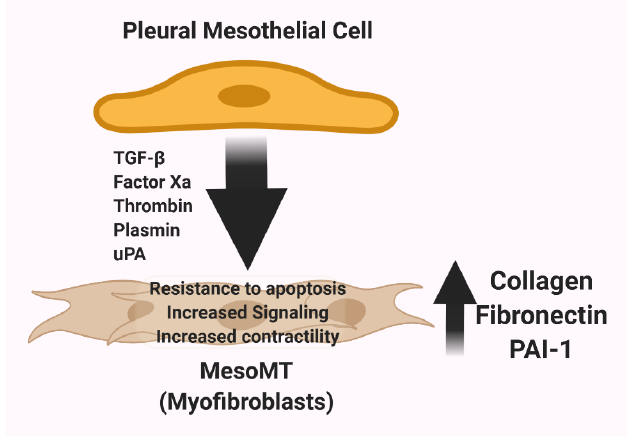
Figure 3. Induction and consequences of MesoMT. Upon stimulation by TGF-β, Factor Xa, throm- bin, uPA, or plasmin, pleural mesothelial cells assume a mesenchymal phenotype by undergoing MesoMT. The population of cells undergoing MesoMT expands in the setting of organizing pleu- ral inflammation. Cells undergoing MesoMT elongate compared to unstimulated pleural mesothe- lial cells and assume the functionality of myofibroblasts and increase expression of neomatrix components including collagen, fibronectin, and PAI-1. 5. The Role of Soluble uPAR in Pleural Injury: Biomarker, Effector, or Both? The structure of uPAR incorporates three domains: DI-III. High affinity binding to its ligand, uPA, primarily involves domain I, while requiring the structural integrity of all three domains [86]. Although a splice variant of the PLAUR gene can generate a soluble uPAR construct [87], soluble uPAR is also generated by cleavage of cell-surface uPAR and occurs in serum and other biologic fluids, including pleural effusions [88,89]. suPAR can be generated by cleavage of the GPI-anchor of uPAR at the cell surface by enzymes such as phospholipase C [90]. Cleavage of a protease sensitive linker region between domains I and domains II-III can also occur via uPA or plasmin among other proteases. Thus, sol- uble suPAR fragments include domains I-III, I or II-III, as previously reviewed [88]. su- PAR, incorporating all domains, retains the ability to bind uPA, via its growth factor do- main [91], supporting the concept that this form of suPAR could be a scavenger capable of binding uPA and thereby altering effects of the interaction of uPA with cell surface uPAR such as migration or invasion. Interestingly, Higazi and colleagues reported that binding of the proenzyme single chain uPA to suPAR increased its catalytic activity [92]. The authors speculated that scuPA exists in a latent and more active state and that binding of scuPA to suPAR favored the more active conformation, which was more susceptible to inhibition by PAI-1. On the other hand, these observations were disputed by Behrendt and colleagues, who found that the binding of scuPA to suPAR did not accelerate the PA activity of scuPA and in fact had an inhibitory effect on the activation of scuPA to two chain more active uPA by plas- min [93]. The basis for the disparities between these studies remain unclear but are possi- bly technical. Liberation of domain I from suPAR exposes a chemotactic sequence on the remaining domains (II-III), most of which may be shed from neutrophil membranes, which is a chemotaxin for monocytic cells [94]. Conversely, suPAR domain I has poor affinity for scuPA or uPA and is thereby unable to serve as a scavenger binding either protein [88]. In a recent study, pleural fluid suPAR levels were found to correlate with the require- ment for invasive management in parapneumonic pleural effusions [89]. This work ex- tends prior work showing that elevated levels of suPAR occur in a range of biologic fluids in infectious, autoimmune and neoplastic diseases, as previously reviewed [88]. Given the